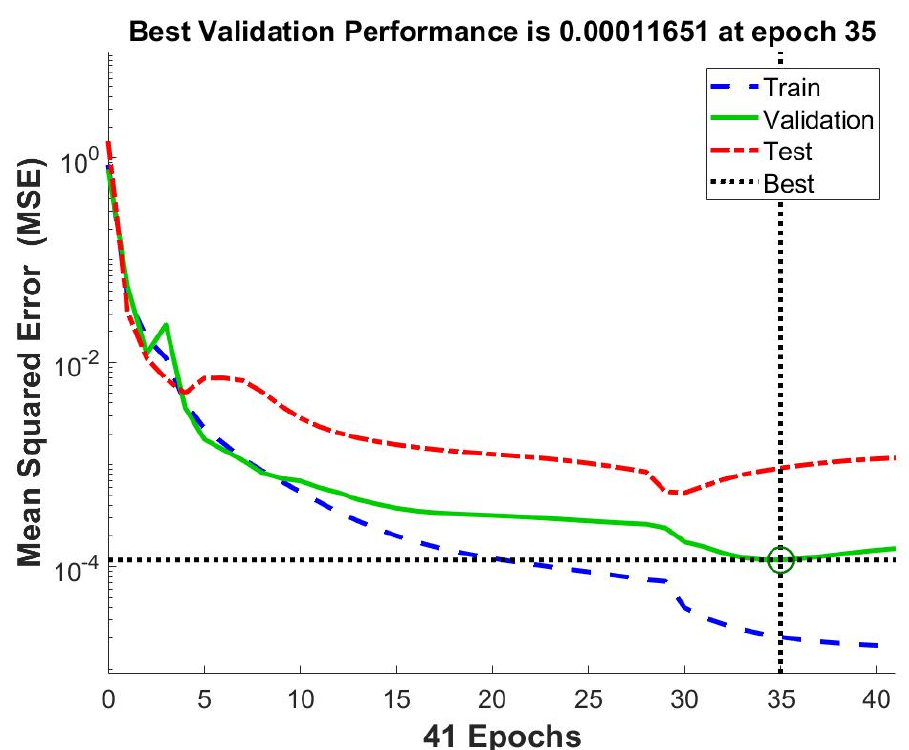
Figure 5. The training performance graph of the developed MLP neural network.